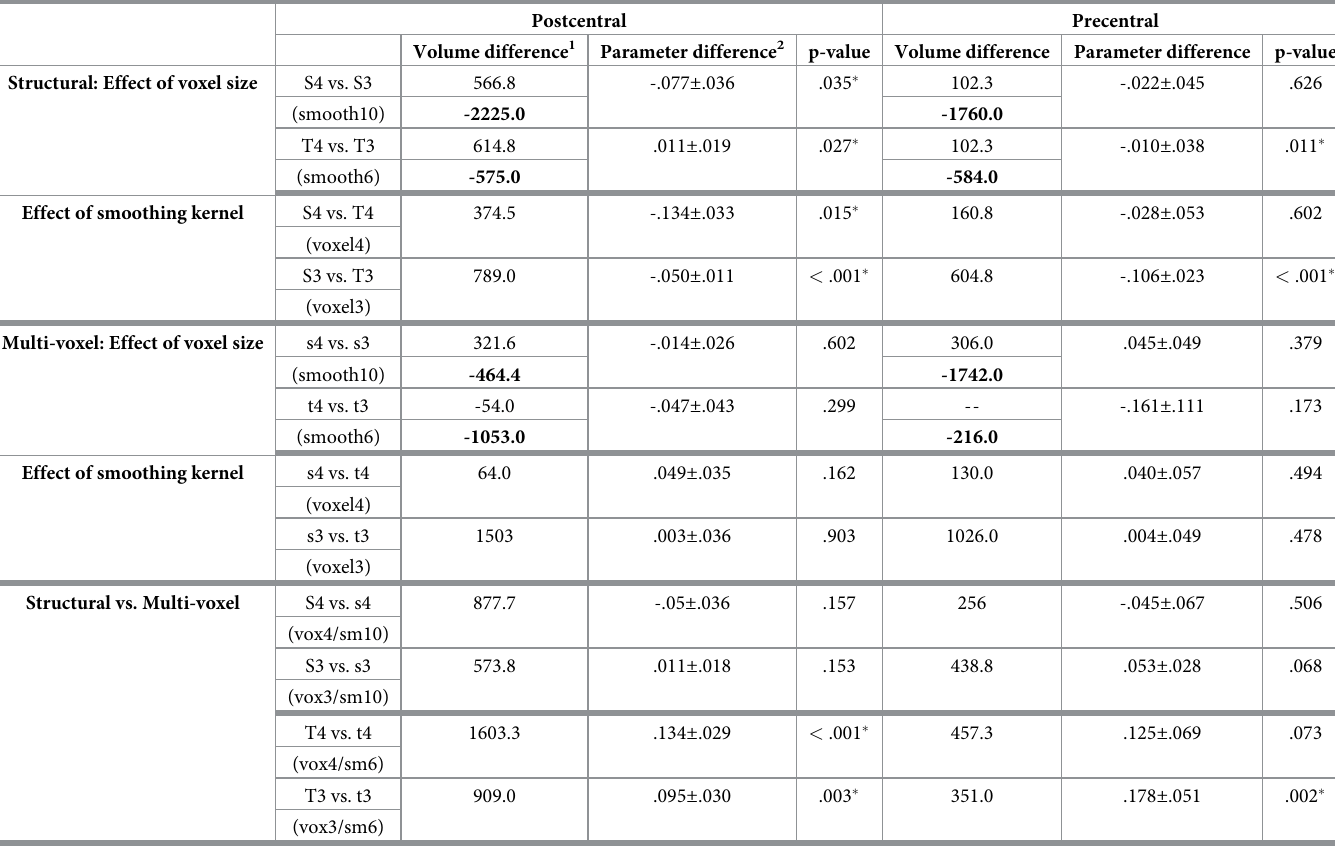
Table 6. Statistical effects of different methods of connectivity analysis across all anatomical locations during sequence